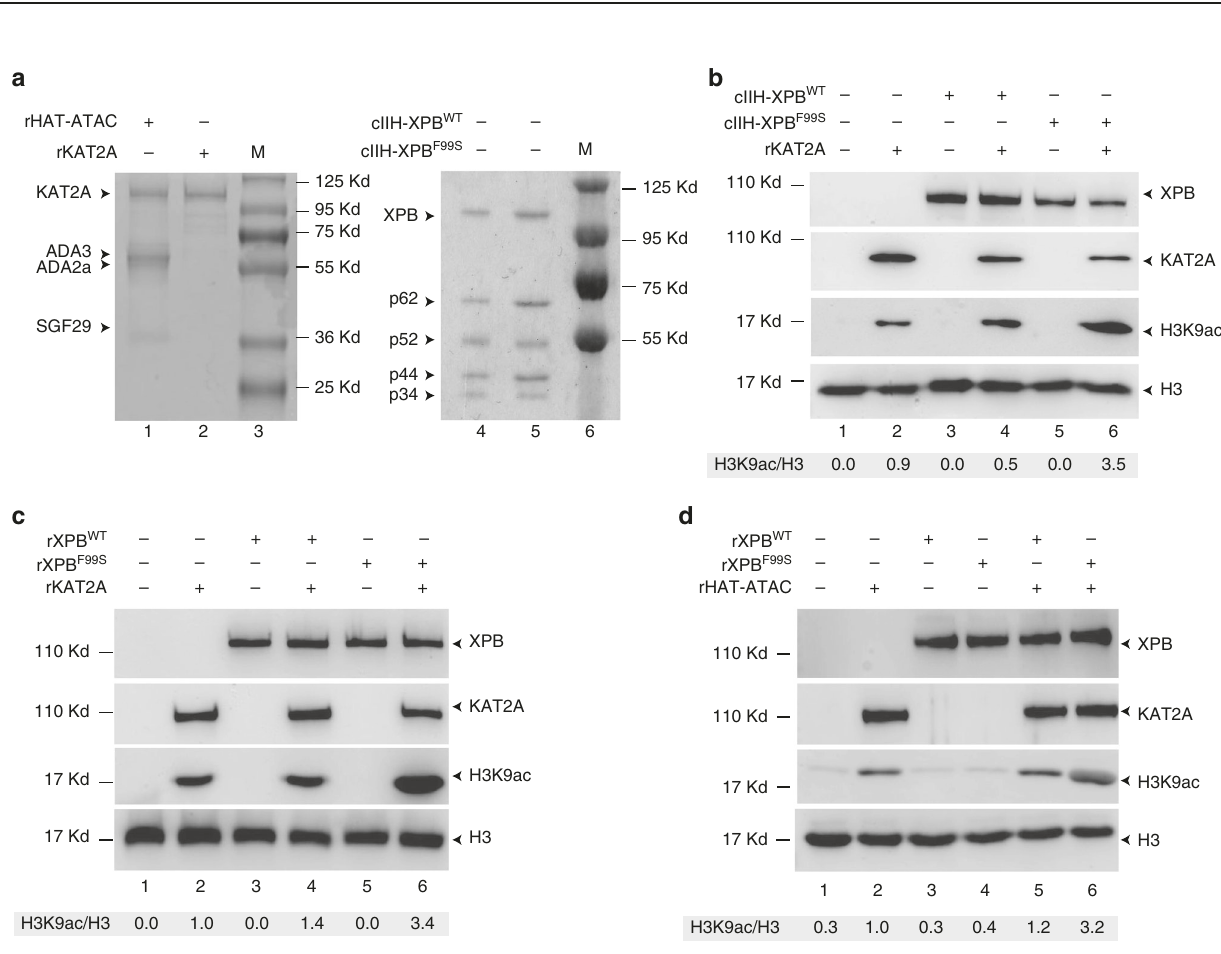
Fig. 4 Loss of XPB NTD integrity induces an increase in KAT2A HAT activity. a rKAT2A and the recombinant HAT-ATAC module (rHAT-ATAC) containing KAT2A, ADA3, ADA2a, and SGF29 were resolved by SDS-PAGE followed by Coomassie staining. Core TFIIH containing p62, p52, p44, p34 and either XPB WT (cIIH-XPB WT ) or XPB F99S (cIIH-XPB F99S ) were resolved by SDS-PAGE followed by Coomassie staining. Source data are provided as a Source Data fi le. b One hundred nanograms of core TFIIH containing either XPB WT (cIIH-XPB WT ) or XPB F99S (cIIH-XPB F99S ) were incubated with 50 ng